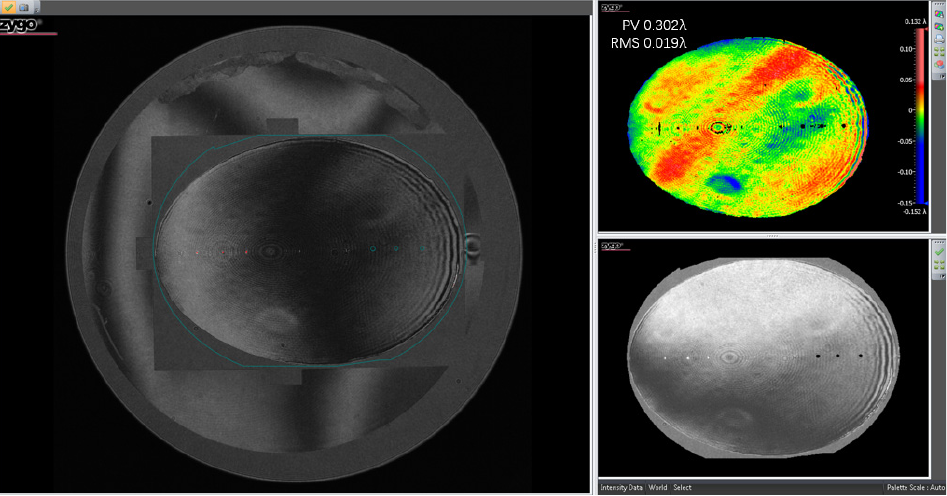
Figure 25. The mirror surface error after temperature test.